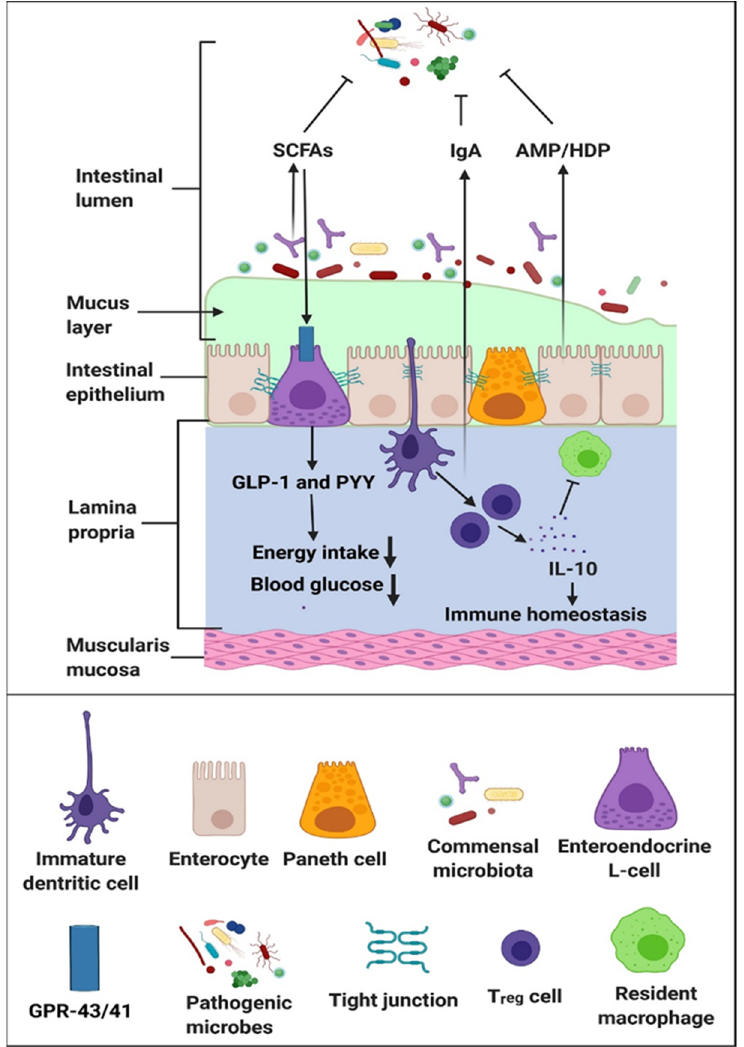
Figure 2. Fecal microbiota transplant restores intestinal microbial composition to modulate the adaptive immune responses, re-establish intestinal microbial homeostasis, and alter the host metabolism. Short chain fatty acids such as butyrate and propionate interact with G-protein coupled receptors GPR-43/41 on L cells to produce glucagon-like peptide 1 (GLP-1) and peptide YY (PYY), which contributes to reducing food intake and improving glucose metabolism [17].